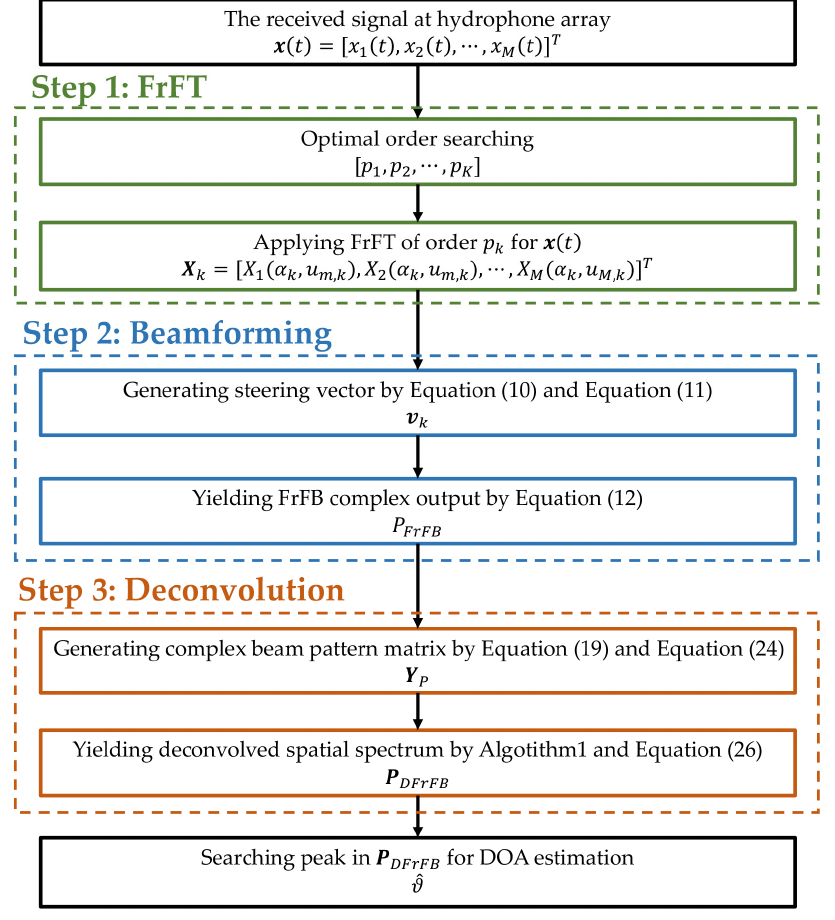
Figure 1. Flowchart of the proposed DFrFB method.